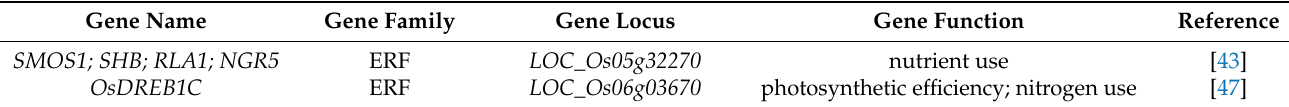
Table 8. Genes associated with nutrient use in